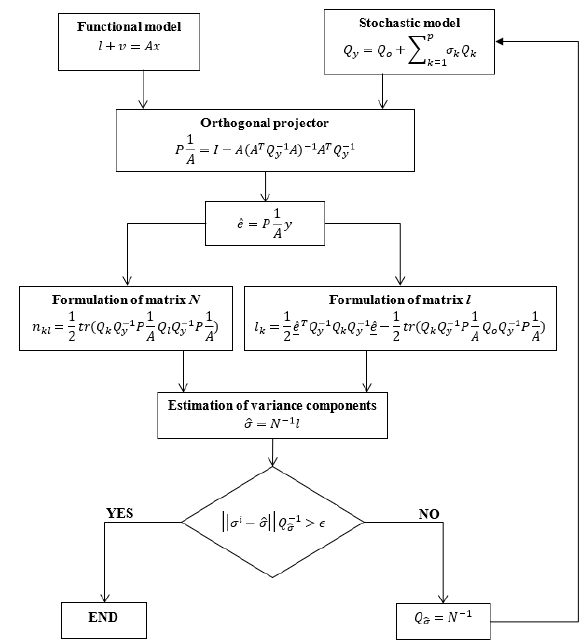
Figure 5. The computation procedure of variance covariance components using LS-VCE method.